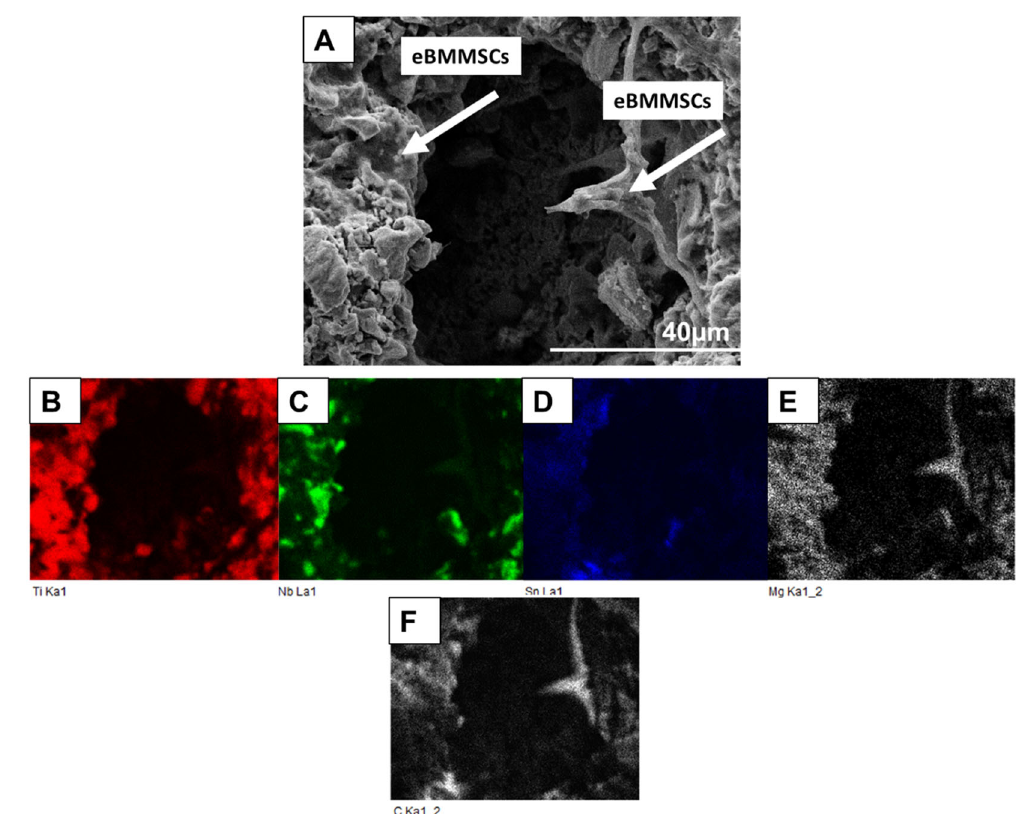
Fig. 5 A SEM micrograph of Ti-Nb-Sn alloy with eBMMSCs on the surface ( B – F ) elemental map of Ti, Nb, Sn, Mg and C by EDS detector. ×3000 magni fi